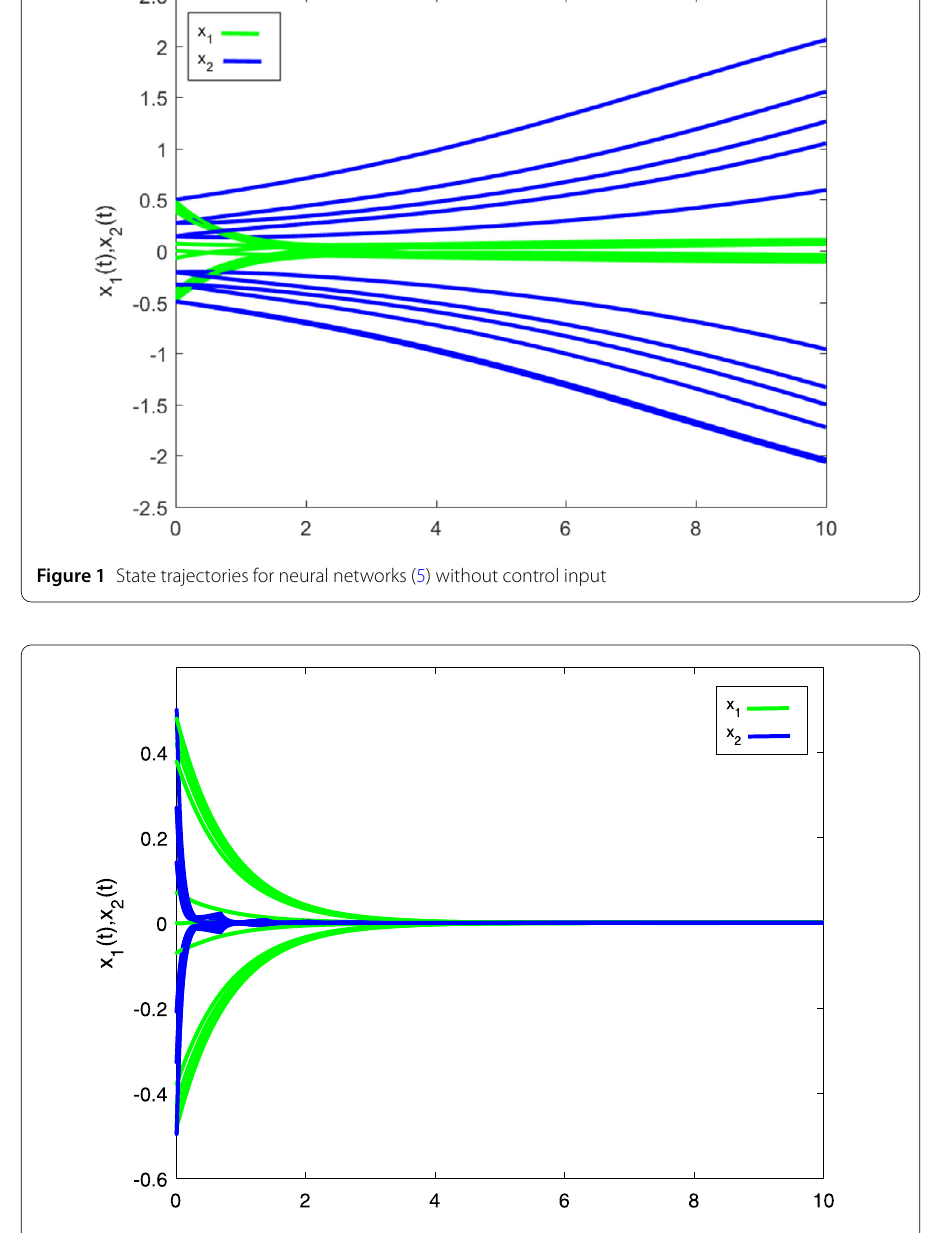
Figure 2 State trajectories for neural networks (5) with delayed intermittent controller